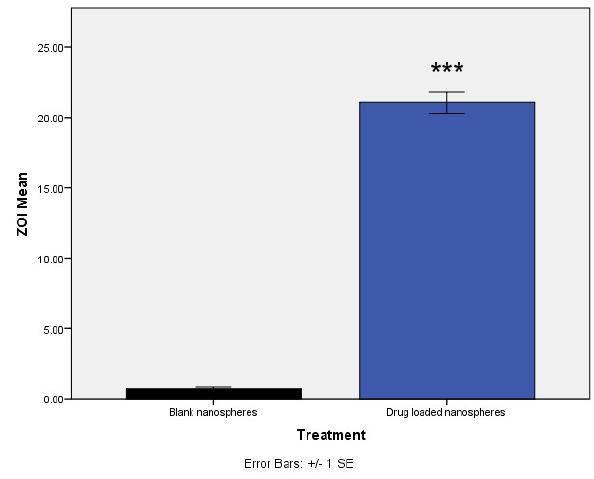
Figure 6. ZOI of blank and drug-loaded nanospheres at MIC (*** p < 0.001).